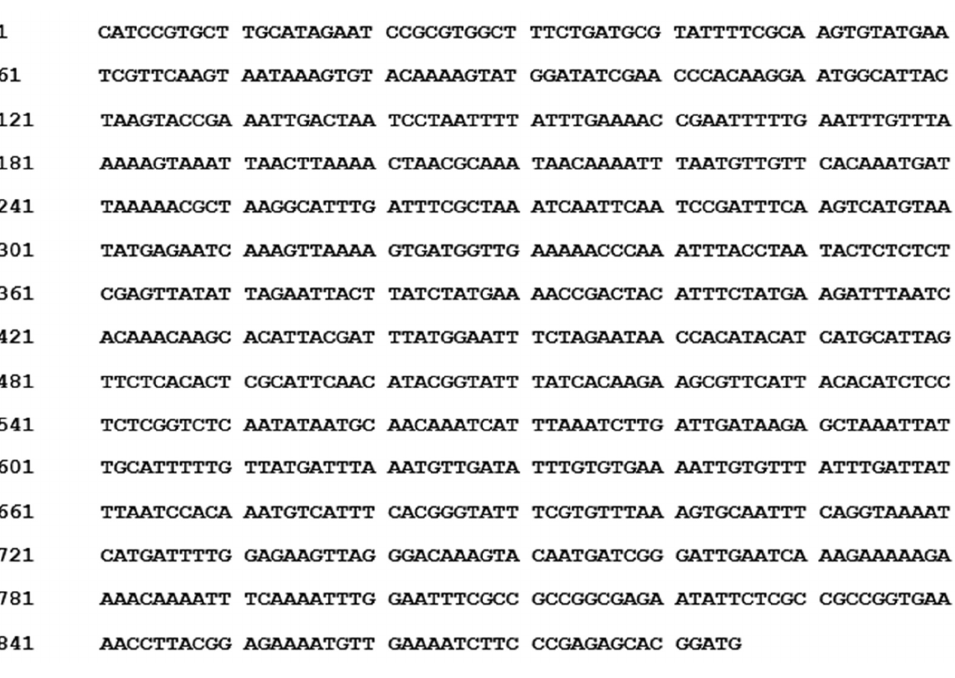
Figure 3. Nucleotide Sequence of the RAPD Amplicon Hrcx-15.